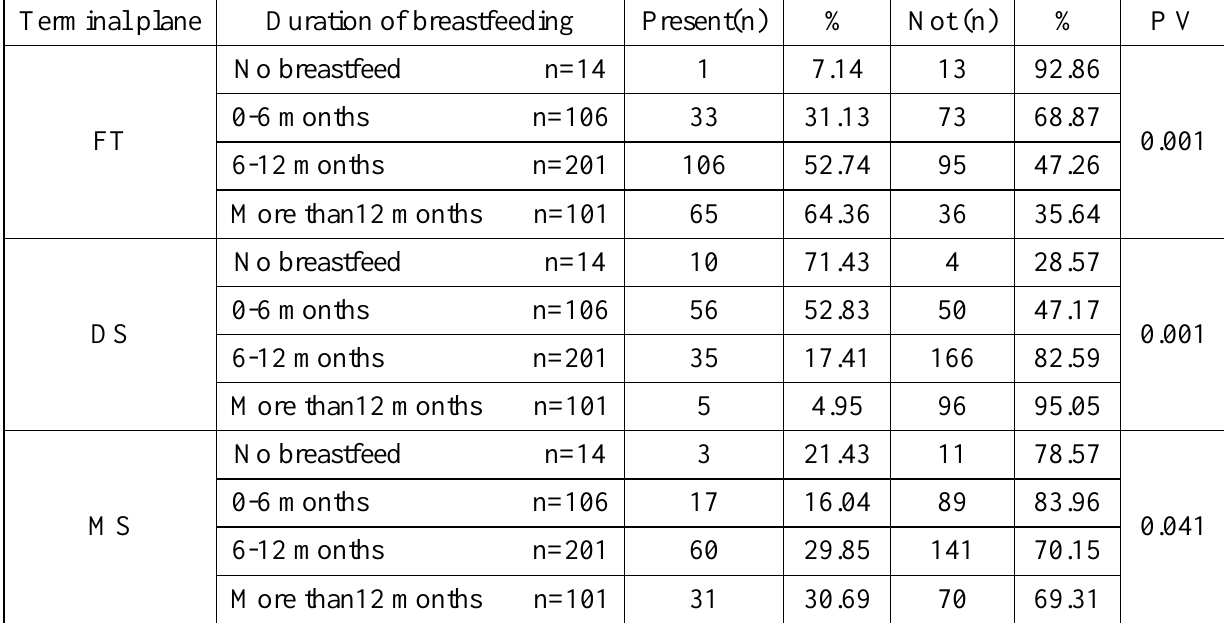
Table 5: the relation of breastfeeding duration and the presence of terminal plane relations types